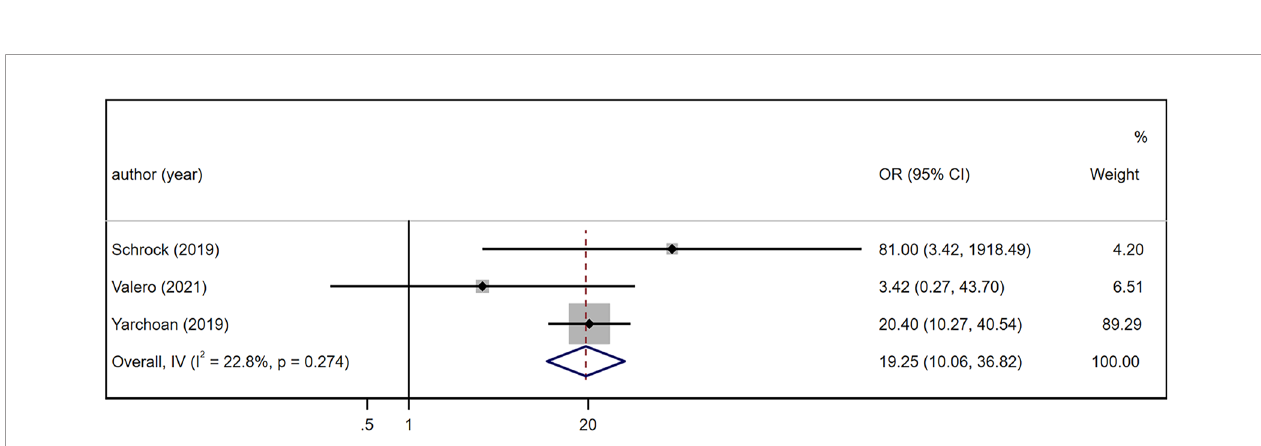
FIGURE 3 | Forest plot of meta-analysis results of the association between objective response rate and TMB. TMB, tumor mutation burden; OR, odds ratio; CI, con fi dence